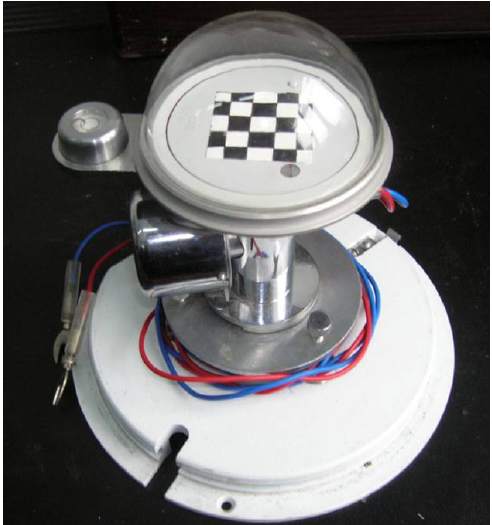
Figure 15. Comparison of experimental tools.